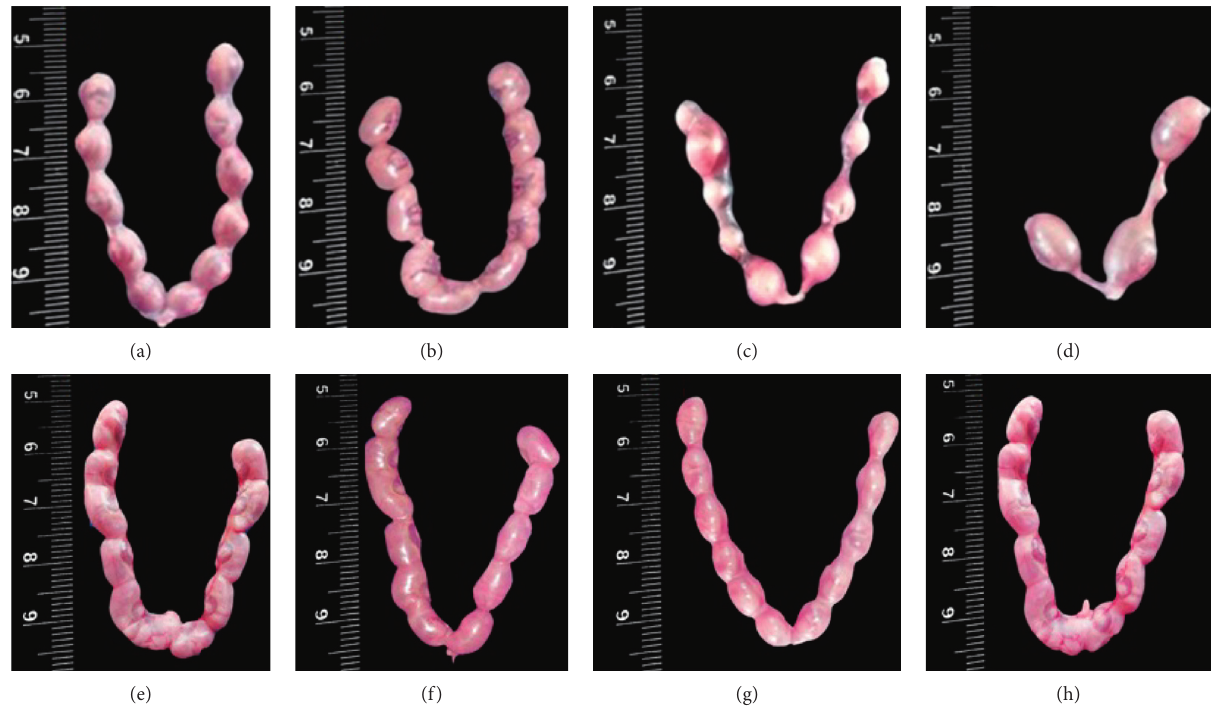
Figure 2: Postimplantations on the 18 th day of pregnancy of female mice cohabitated both baicalein (BC)-exposed without or with testosterone (T)-injected male mice. (a) and (e) Control. (b), (c), and (d) 30, 60, and 90mg · BC/kg body weight (BW) exposed F1 males, respectively; (f), (g), and (h) 30, 60, and 90mg · BC/kg BW exposed F1 males administered with 4.16mg · T/kg BW, respectively.